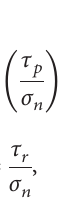
Figure 1: Pull-out test: (a) test device; (b) sample preparation and dimensions; (c) test